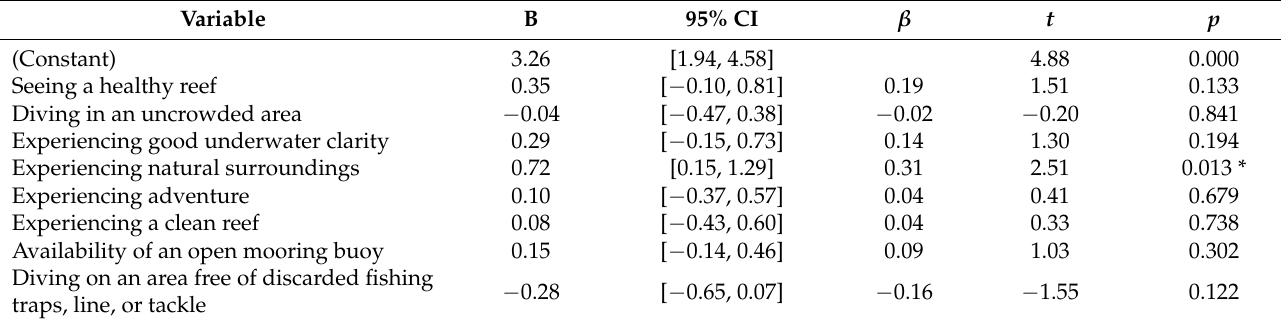
Table 4. Multiple regression results for overall satisfaction level and satisfaction of environmental items.